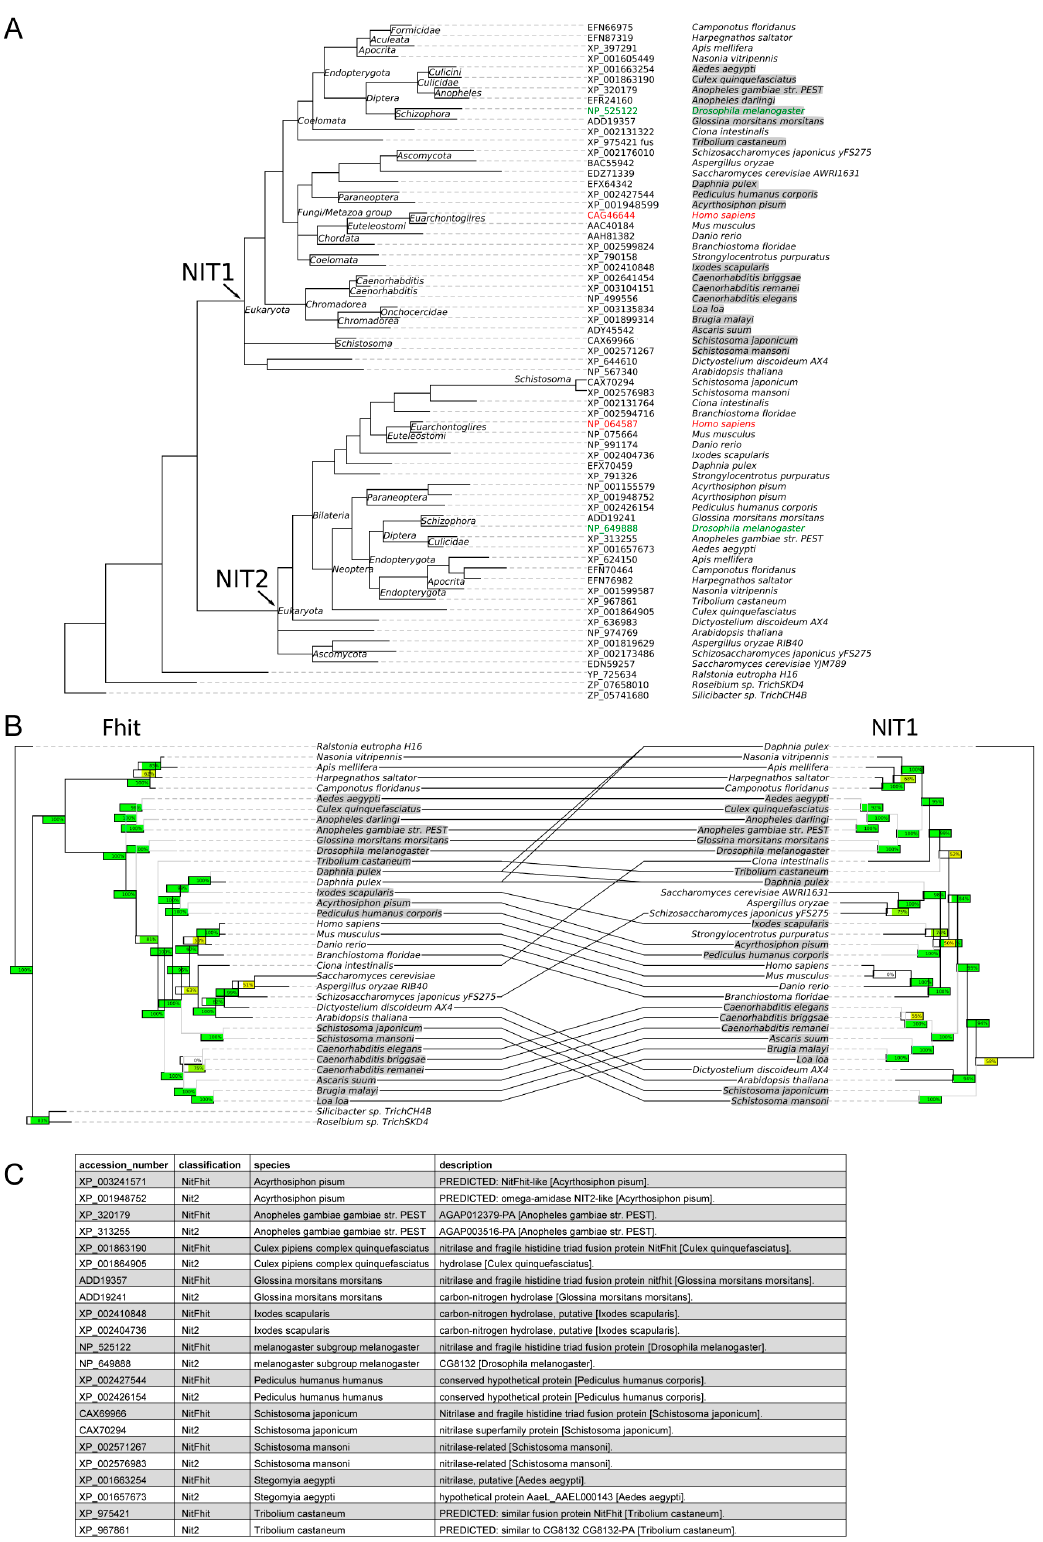
Figure A1. Phylogentic analysis of Nit1/2 and Fhit. For NitFhit fusion genes (shaded in grey), only the respective domain was used, i.e., the Nit domain was used to compare with non-fused nitrilases (absence of shading) and Fhit domain to compare against non-fused Fhit genes. ( A ) Pylogenetic tree of Nit1 and Nit2 orthologs across selected eukaryota. The first label column represents NCBI